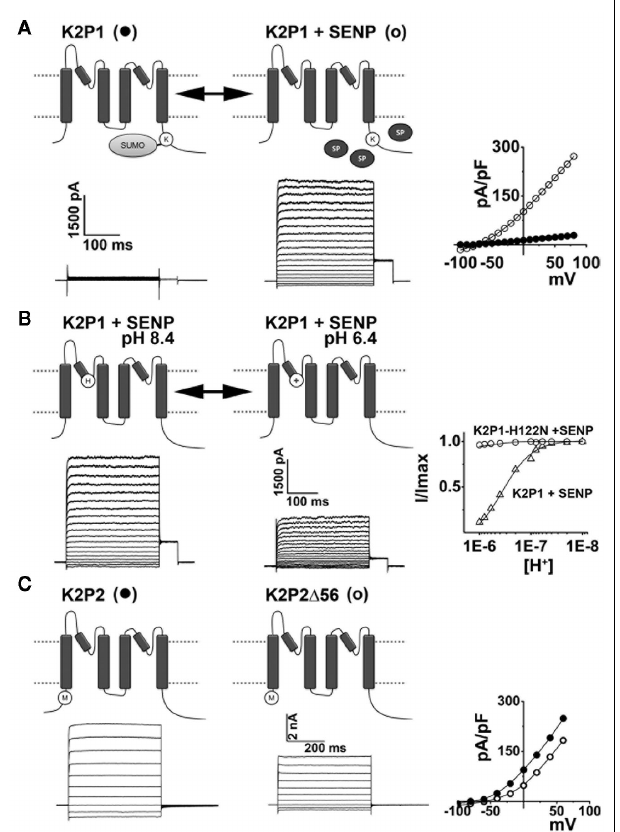
FIGURE 3 | K2P channels are subject to regulation by diverse mechanisms. The operation of K2P channels is tightly controlled, both acutely and in the long-term, by a plethora of stimuli and regulatory pathways. (A) K2P1 channels are constitutively covalently modified at lysine residue 274 (K) by the small ubiquitin-like modifier protein, SUMO. Sumoylation silences K2P1 but is reversed by the action of SUMO-specific proteases (SENP, SP) to reveal active channels that mediate K + selective leak currents in excitable cells such as neurons and cardiac myocytes. Example current-families and current–voltage relationships for K2P1 alone • ( ) and K2P1 in the presence of SENP ( (cid:2) ) are shown; adapted from Plant et al. (2010). (B) Acid-sensitive K2P (TASK) channels have a histidine (H) adjacent to the K + selectivity filter in the first P-loop.Thus, K2P3, K2P9, and active K2P1 channels pass currents that are reversibly blocked by protonation of this residue during acidification. Example currents-families for active K2P1 channels (in the presence of SENP) are shown at external pH 8.4 and 6.4.The proton-dependent block of active K2P1 channels is plotted ( Δ ) and shows that half-block occurs at pH 6.7. Active K2P1 channels in which the protonatable histidine is substituted for an asparagine residue are not sensitive to external acidification ( (cid:2) ); adapted from Plant et al. (2010). K2P18 channels from rodents and other mammals are also acid-sensitive however, primate clones have a tyrosine rather than a histidine in the first P-loop and thus, human K2P18 channels are insensitive to acidification. (C) Full-length K2P2 channels mediate K + selective leak currents. Alternative translation initiation of KCNK2 mRNA transcripts results in K2P2 Δ , a subunits that lack the first 56 residues of the intracellular N-terminus. K2P2 Δ is expressed throughout the brain and spinal cord at levels that change throughout development and pass smaller currents than full-length channels because of an increased permeability to Na + under physiological conditions. Example current-families and • current–voltage relationships for full-length ( ) and Δ 56 variants of K2P2 ( (cid:2) ) are shown; adapted fromThomas et al.